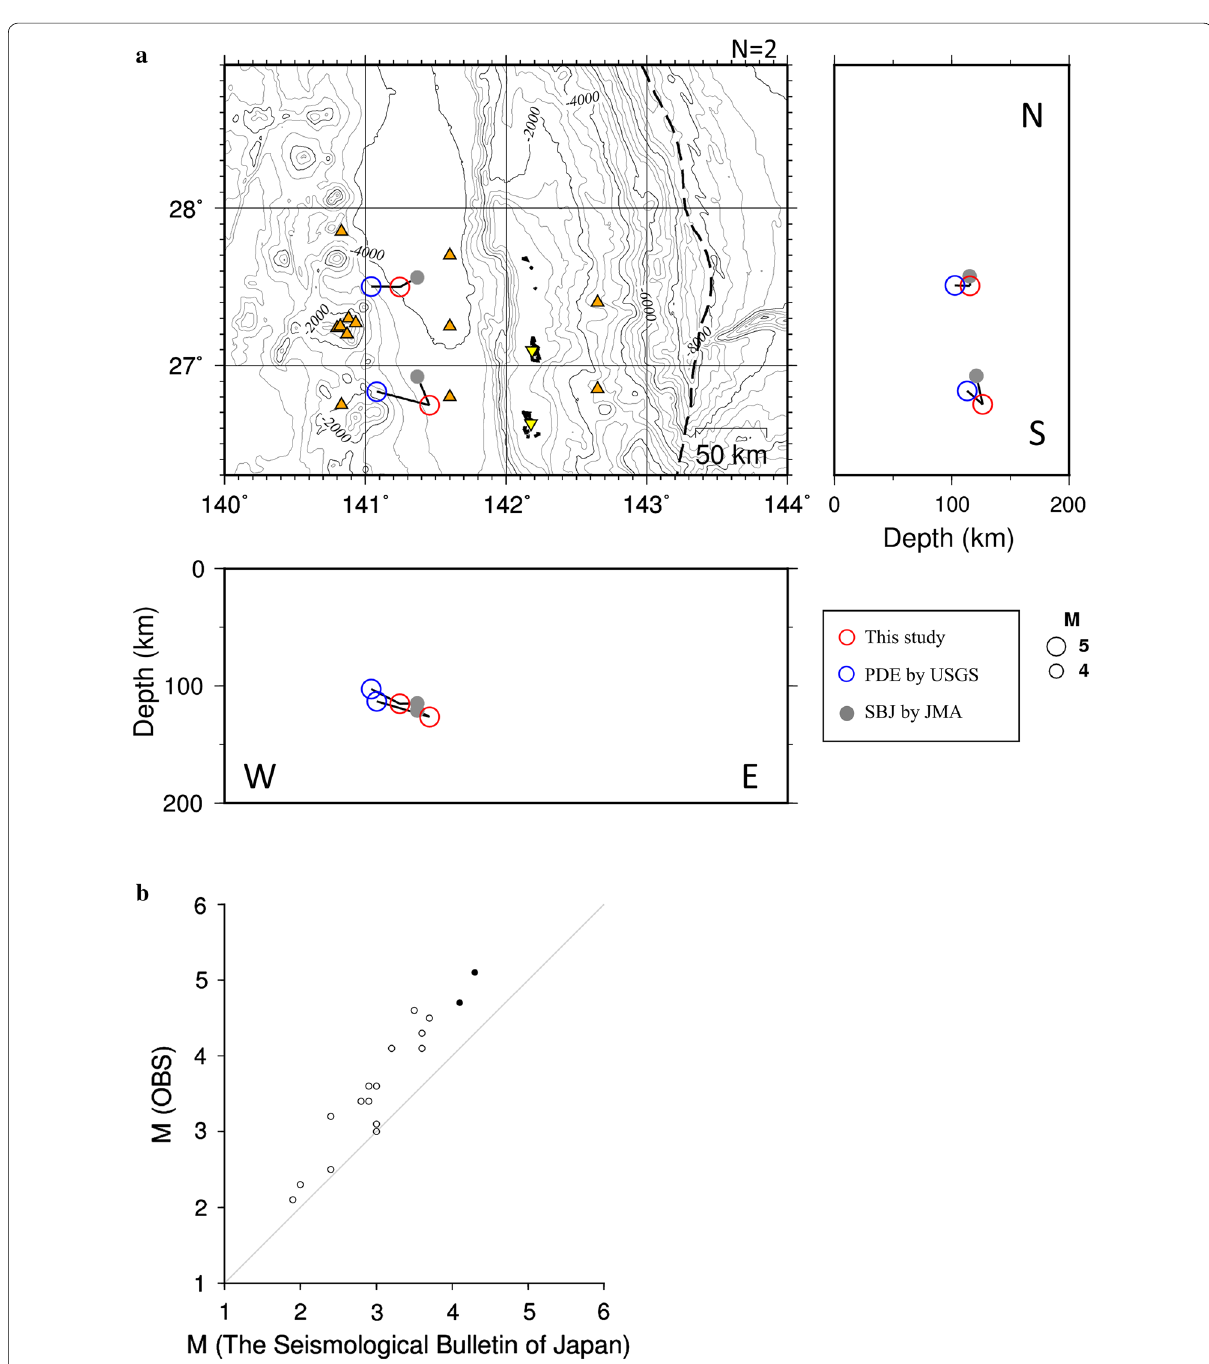
Fig. 6 Comparison of hypocenters. a Map view and N–S and E–W vertical cross sections comparing SBJ hypocenters (gray circles) with corresponding hypocenters determined in this study (open red circles) and PDE by the USGS (open blue circles). b Relationship between magnitudes determined in this study and SBJ magnitudes. Open and filled circles denote low- and high-precision SBJ hypocenters,